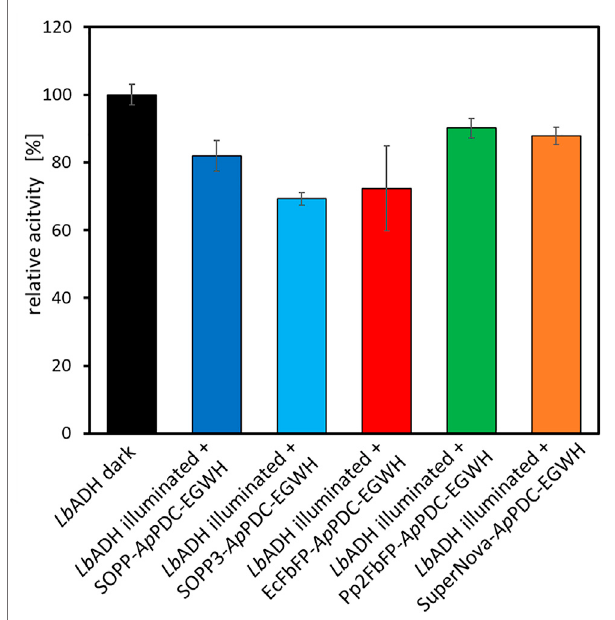
FIGURE 10 | Relative activity of the Lb ADH (0.01 mg ml − 1 ; puri fi ed and lyophilized) after illumination at a concentration of 0.1 mg ml − 1 in combination with SOPP- Ap PDC-EGWH, SOPP3- Ap PDC-EGWH, EcFbFP- Ap PDC- EGWH, Pp2FbFP- Ap PDC-EGWH or SuperNova- Ap PDC-EGWH (1 mg ml − 1 each; puri fi ed and lyophilized). Illumination conditions: 50 mM potassium phosphate buffer (pH 7) with 1 mM MgCl 2 for 10 min with a single blue ( λ max = 450 nm, ~60 mW cm − 2 ) or orange LED ( λ max = 610 nm, ~40 mW cm − 2 ; only for SuperNova- Ap PDC-EGWH) in a stirred quartz-glass cuvette. General reaction conditions: 10 mM benzaldehyde, 10 mM NADPH and 50 mM potassium phosphate buffer (pH 7) with 1 mM MgCl 2 . Incubation on 1 ml scale at 22 ° C and 850 rpm for 2 min in a thermomixer (dark conditions). The activity of the Lb ADH in the dark and without addition of any photosensitizer fusion enzymes served as control. The error bars describe standard deviation of technical triplicates.